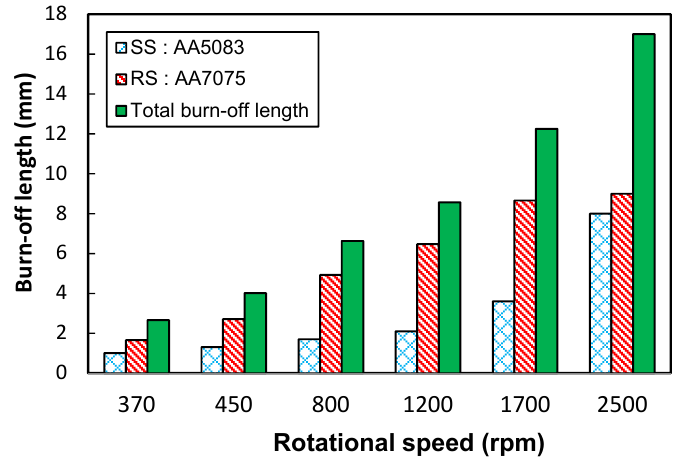
Figure 7. Burn-off lengths of the weld joints under various rotational speeds.